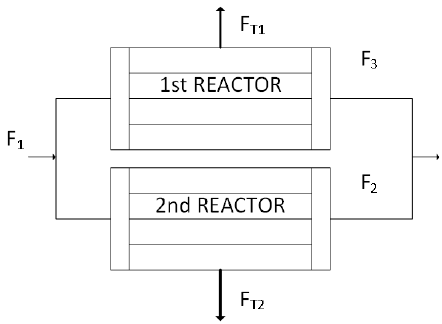
Figure 8. Parallel multi-tube membrane modules.